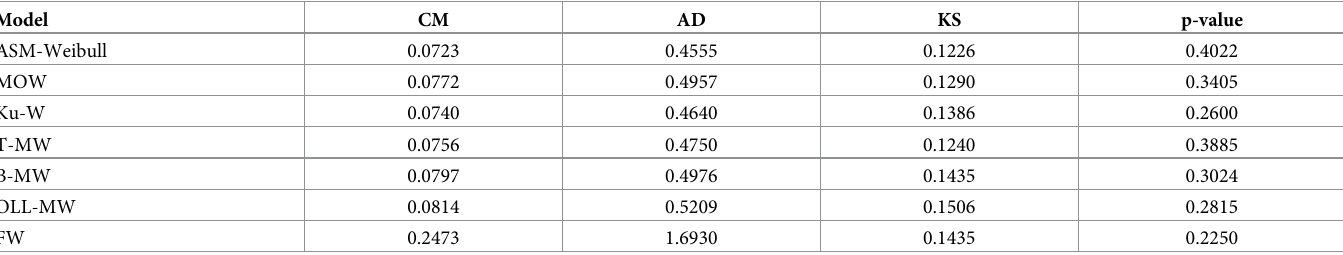
Table 7. Corresponding to the first COVID-19 data, the goodness of fit measures of the fitted models.